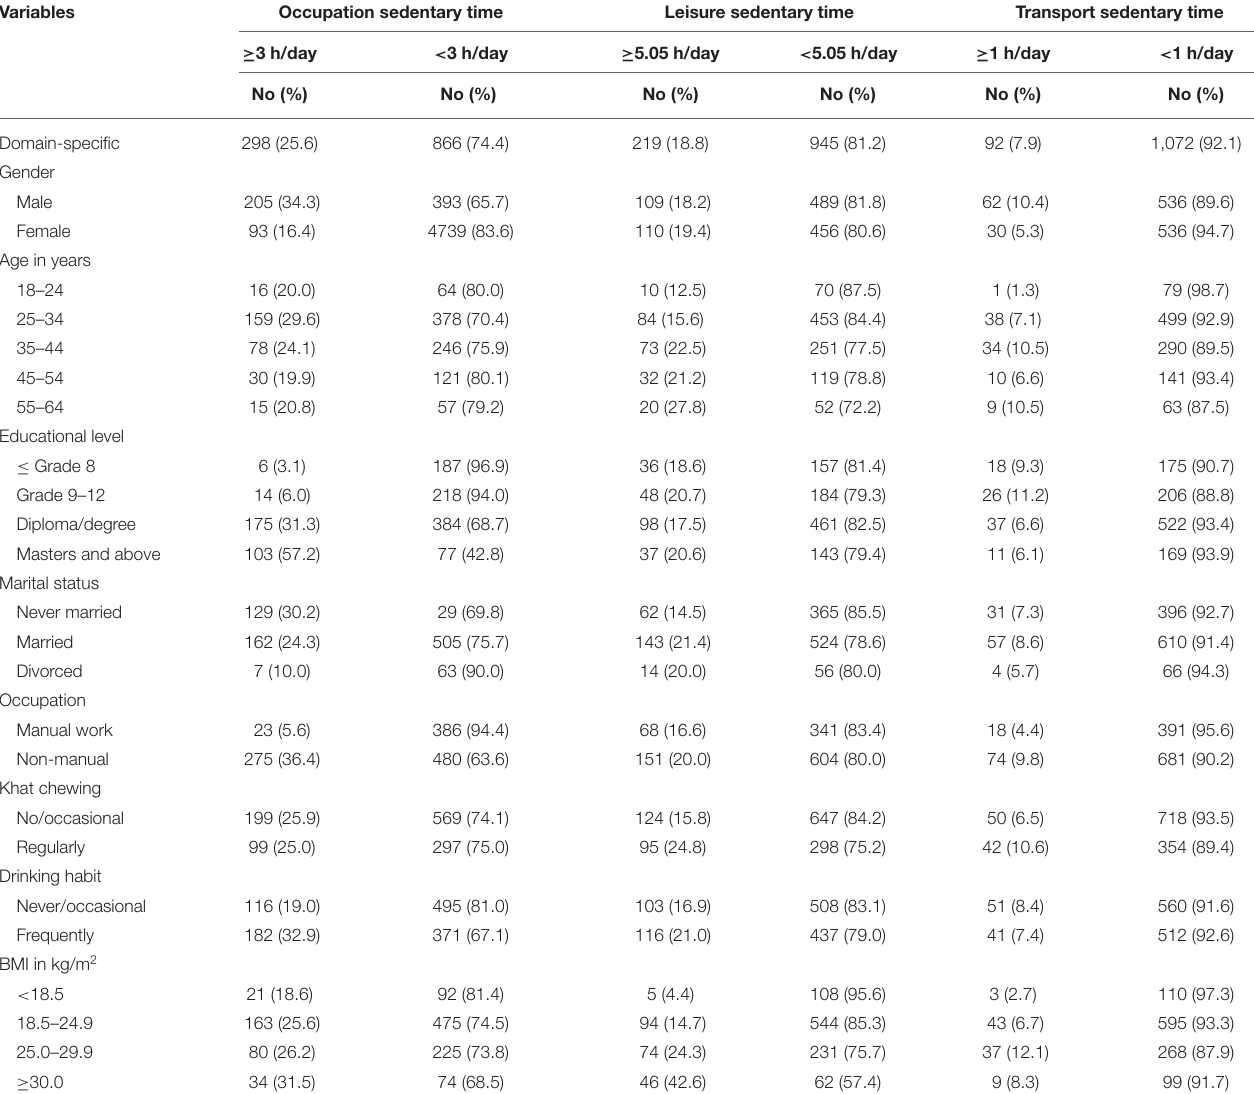
TABLE 6 | Selected characteristics of participants by specific domain occupation, leisure, and transport sedentary time among working adults in Eastern Ethiopia,